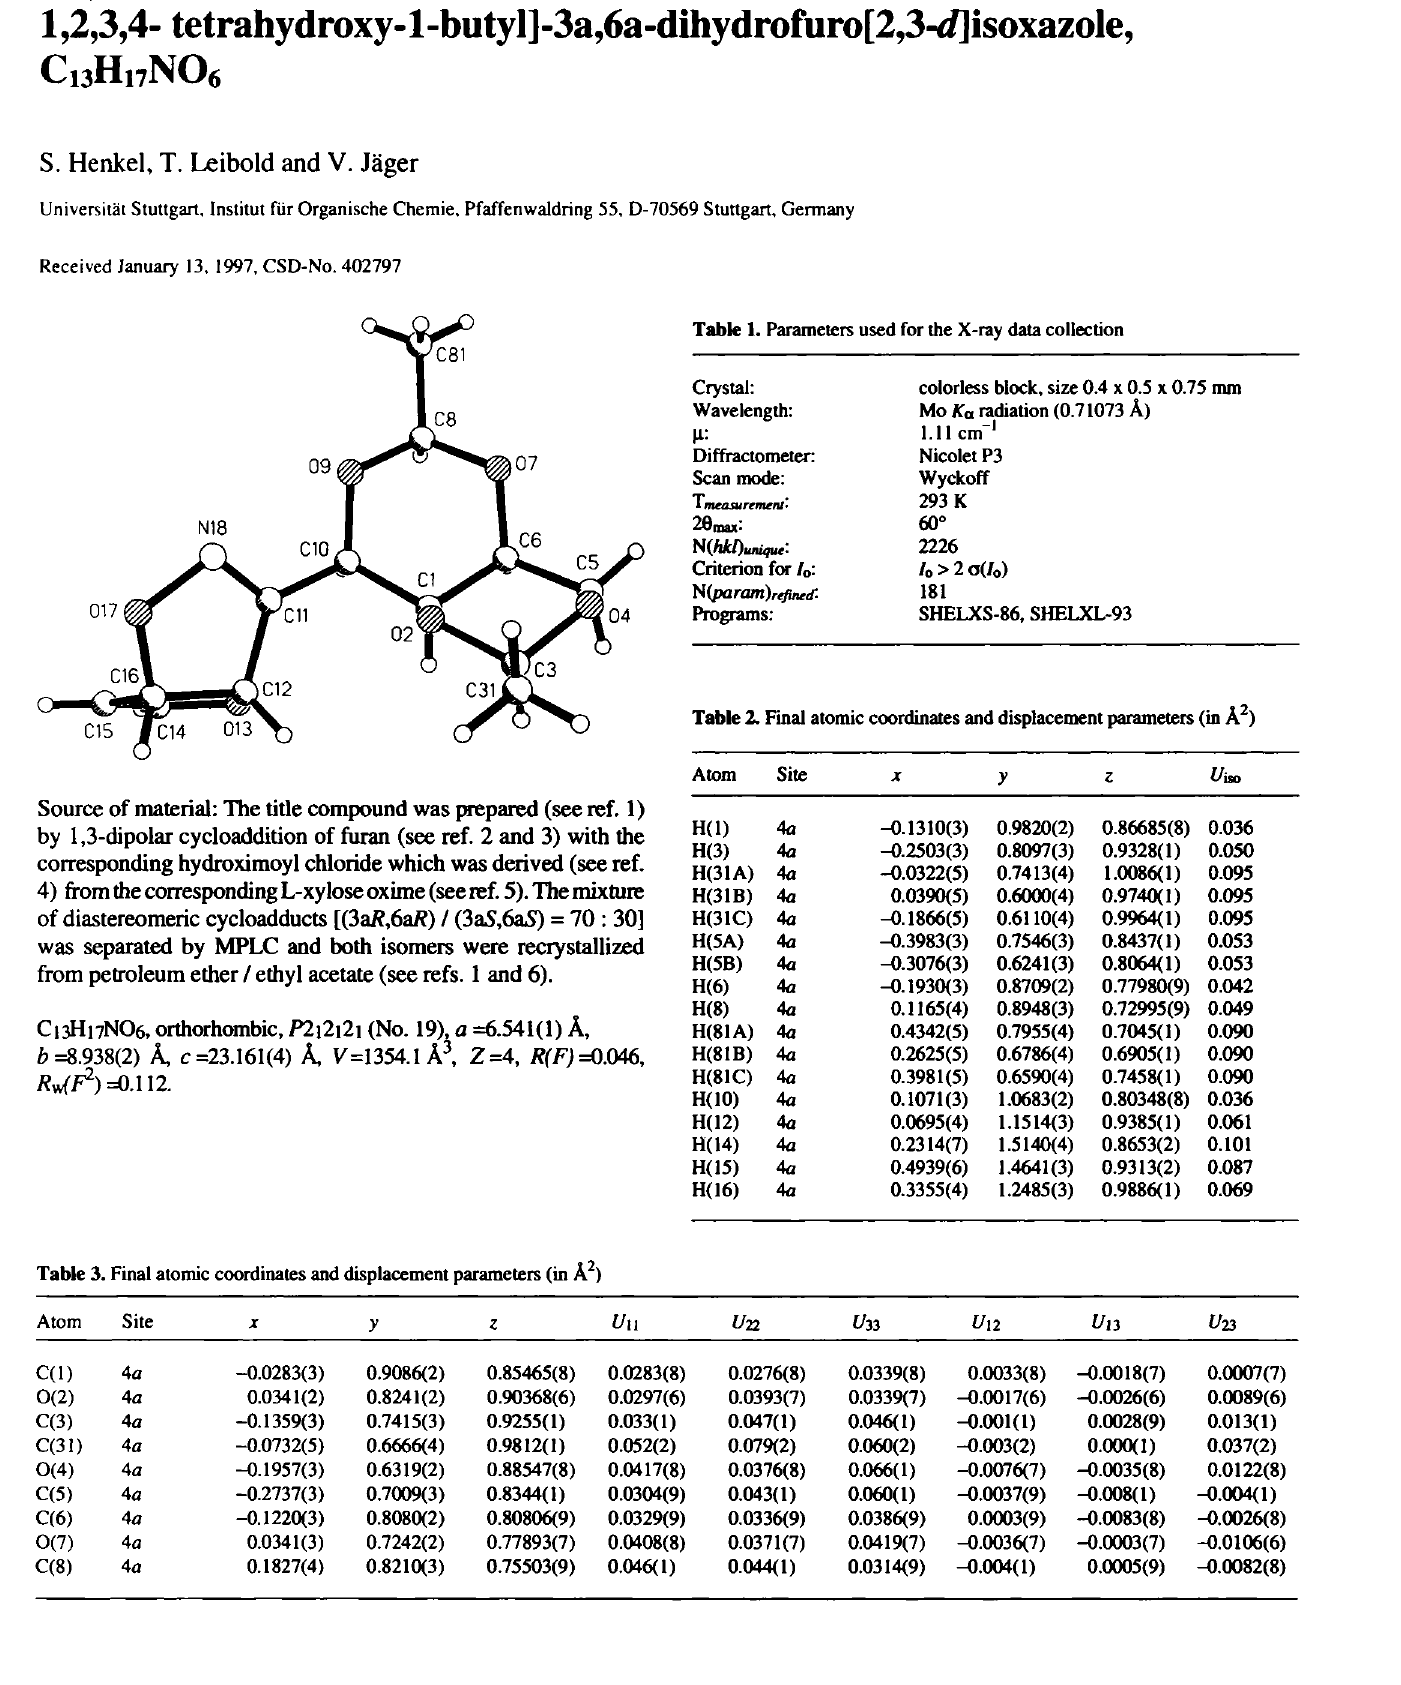
Table 1. Parameters used for the X-ray data collection